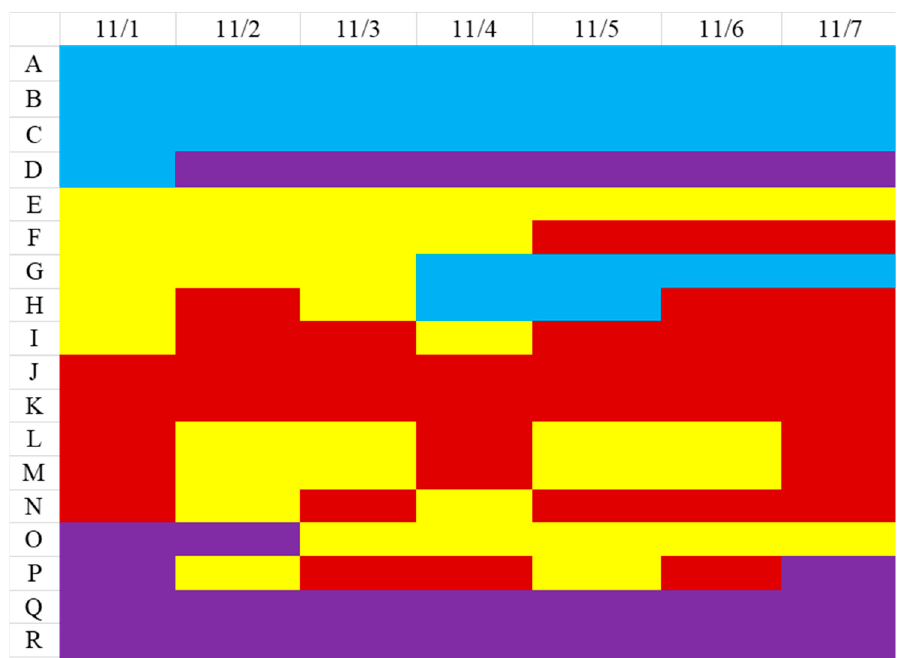
Figure 9. Daily in-bed/off-bed patterns of four types: ( a ) Regular ( b ) Free ( c ) Bedridden ( d ) Leave- home.